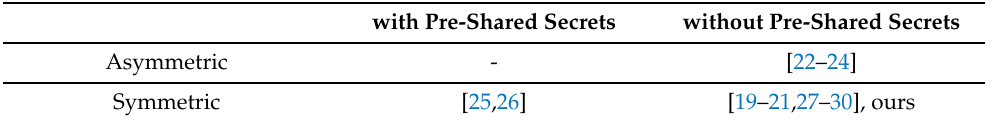
Table 1. Existing Anti-jamming Solution Classification. with Pre-Shared